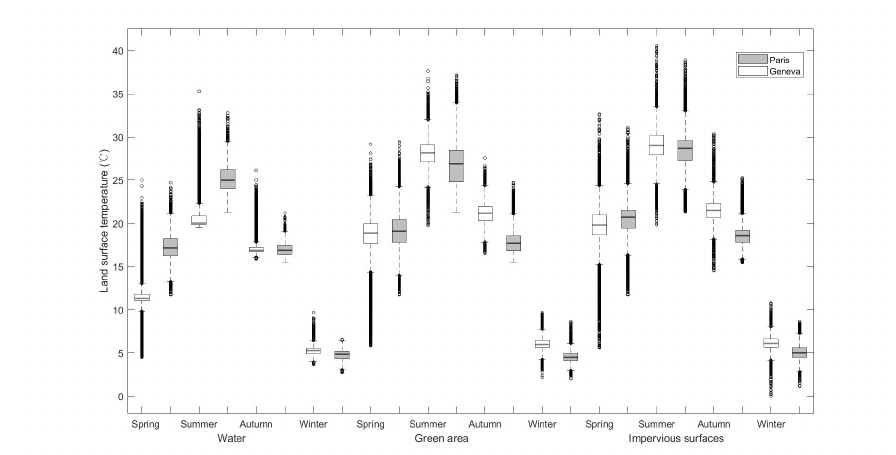
Figure 7. Land surface temperature ( ◦ C) of three land cover features for each season in Paris and